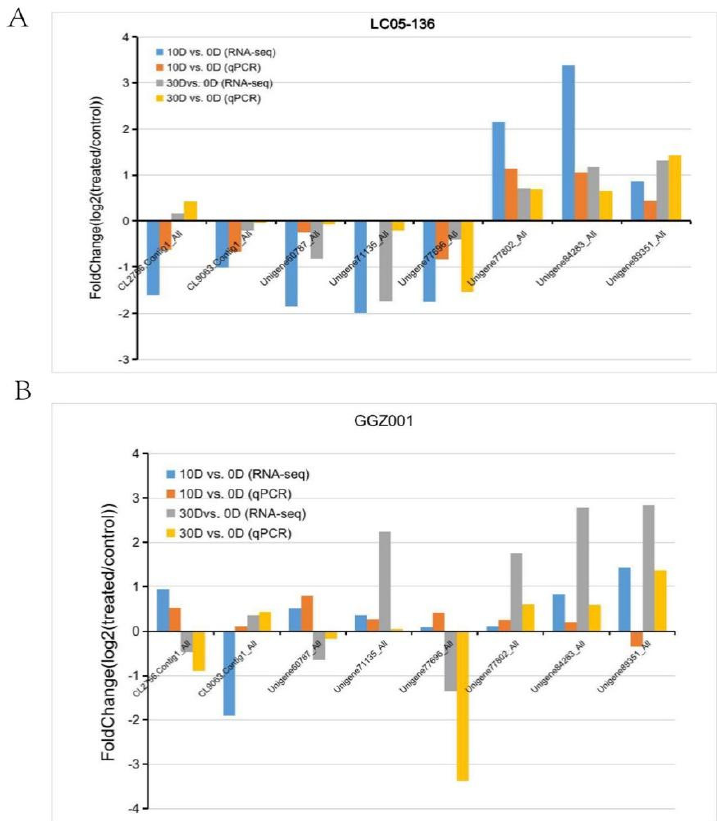
Figure 4. Relative expressions of representative transcripts in LC05 − 136 ( A ) and GGZ001 ( B ) using RT − qPCR.